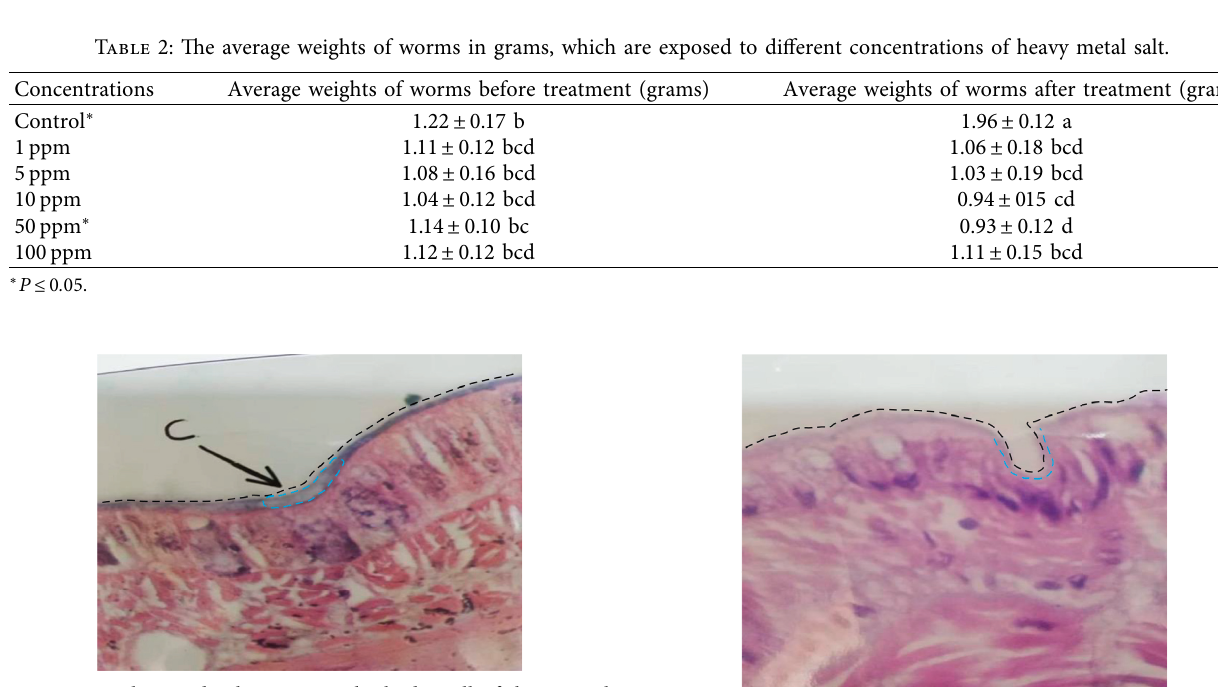
Figure 1: A longitudinal section in the body wall of the control model shows the different tissue layers, and from the top is the cuticle of the connecting tissue. Pigment (H and E) magnification 400.